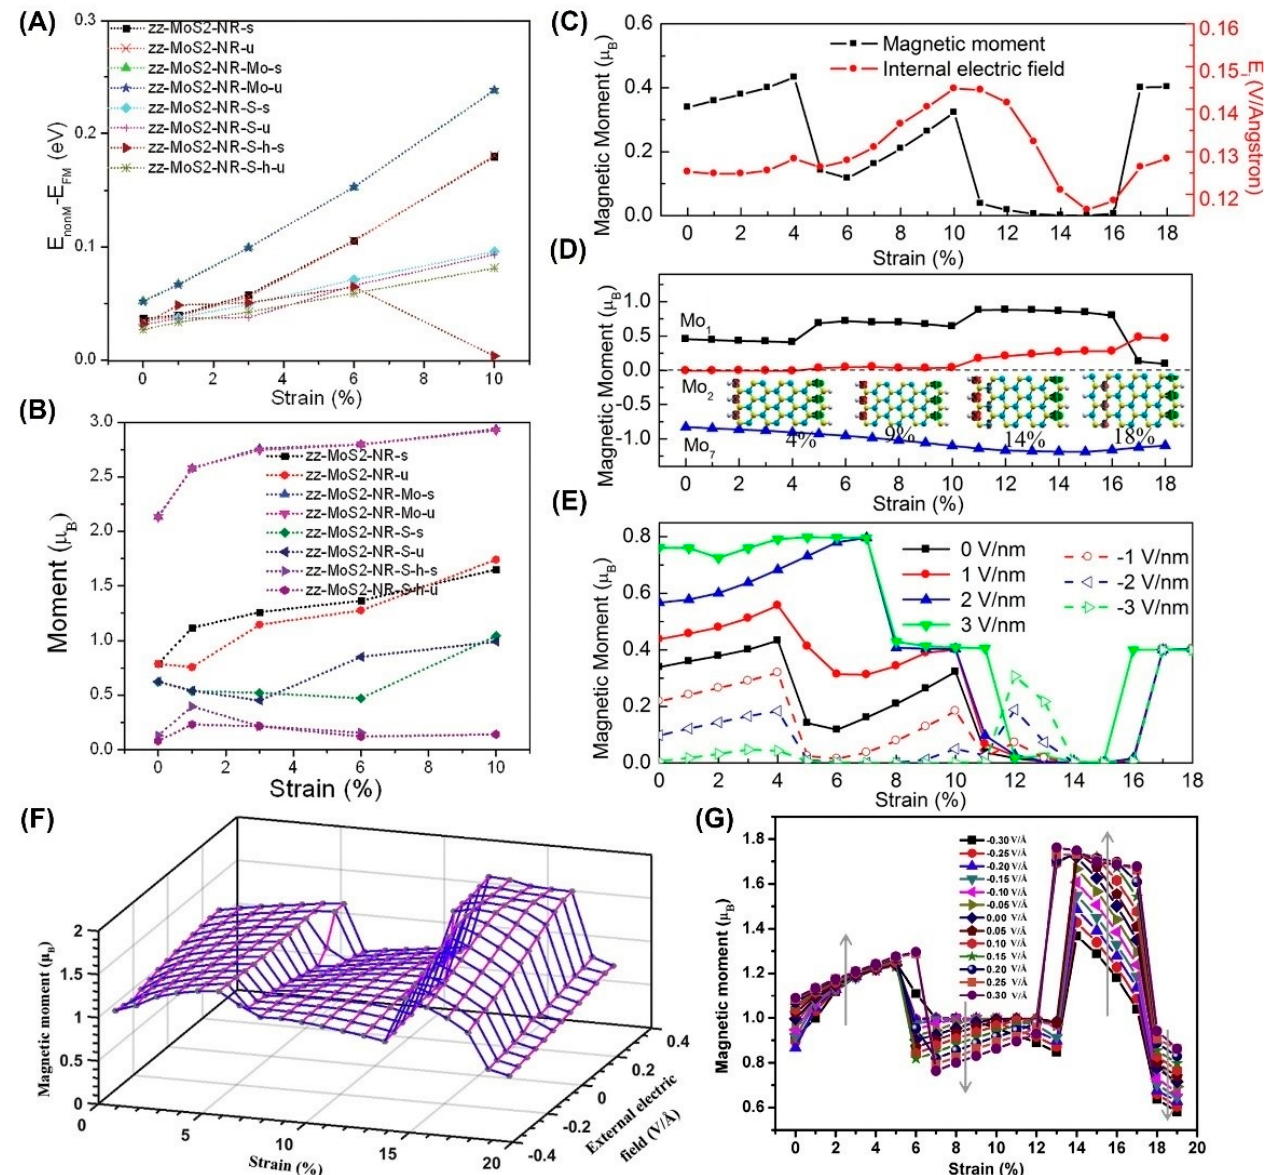
Figure 2. Strain-dependent magnetism in zigzag MoS 2 NRs. ( A , B ) Energy difference and magnetic moment of the zigzag nanoribbons under uniaxial tensile strain along its axis. (Reprinted/adapted with permission from Ref. [51]. Copyright 2012, American Chemical Society). ( C ) Tensile strain-dependent magnetic moment of MoS 2 nanoribbons and the internal electric field across the edges of the ribbon (Reprinted/adapted with permission from Ref. [48]. Copyright 2012, American Chemical Society). ( D ) Magnetic moment on the edge Mo atoms versus strain. (Reprinted/adapted with permission from Ref. [48]. Copyright 2012, American Chemical Society). ( E ) Magnetic moment evolution of the strained MoS 2 nanoribbon under electric fields. (Reprinted/adapted with permission from Ref. [48]. Copyright 2012, American Chemical Society). ( F ) 3D view of the combined effects of strain and external electric field on magnetic moment. (Reprinted/adapted with permission from Ref. [81]. Copyright 2018, Elsevier). ( G ) Magnetic moment versus the strained nanoribbon with different external electric fields (Reprinted/adapted with permission from Ref. [81]. Copyright 2018, Elsevier).